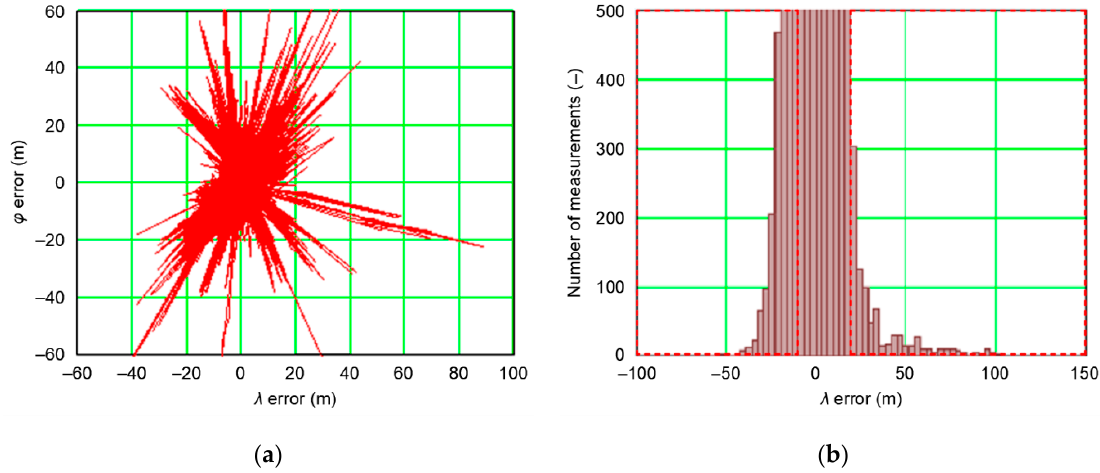
Figure 1. ( a ) European Geostationary Navigation Overlay Service (EGNOS) position error distribution (1’774’705 fixes); ( b ) histogram in relation to the λ with outliers marked in red during the measurement campaign in 2006 [18].